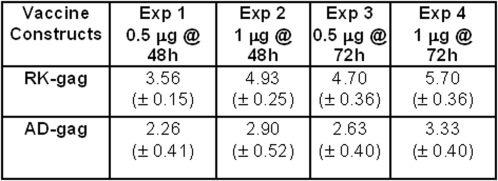
Gag expression in transiently transfected 293 cells.
Figure 1 presents the results from four independent transfection experiments. The results are expressed as the mean P24 value (ng/ml, ±SD) of triplicates. The two different gag sequences are the codon optimized version (AD) and the motif optimized version (RK) that we created. Our (RK) version of the Gag gene has approximately two-fold higher expression than the codon optimized version.